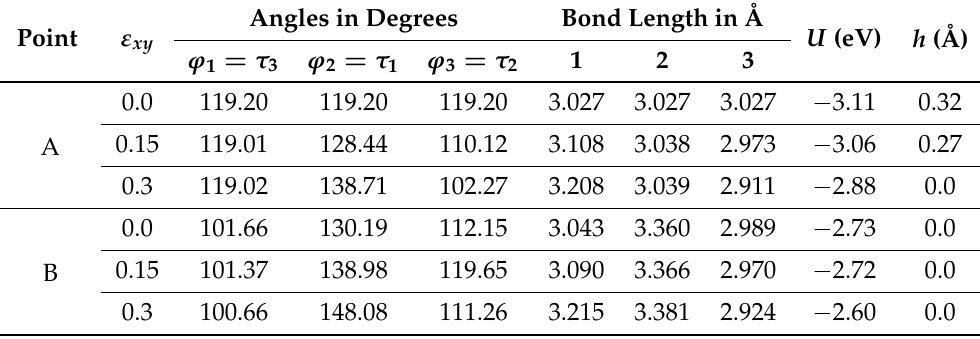
Figure 8. The structure of stanene at point A shown in Figure 7b for the three values of shear strain: ( a , b ) for ε xy = 0; ( c , d ) for ε xy = 0.15, and ( e , f ) for ε xy = 0.3. Other components of strain are ε xx = ε yy = 0.118. Table 2. Parameters of the structures at points A and B marked in Figure 7b. Valence bonds and valence angles are defined in Figure 1b. The potential energy per atom U and the height of stanene h are also